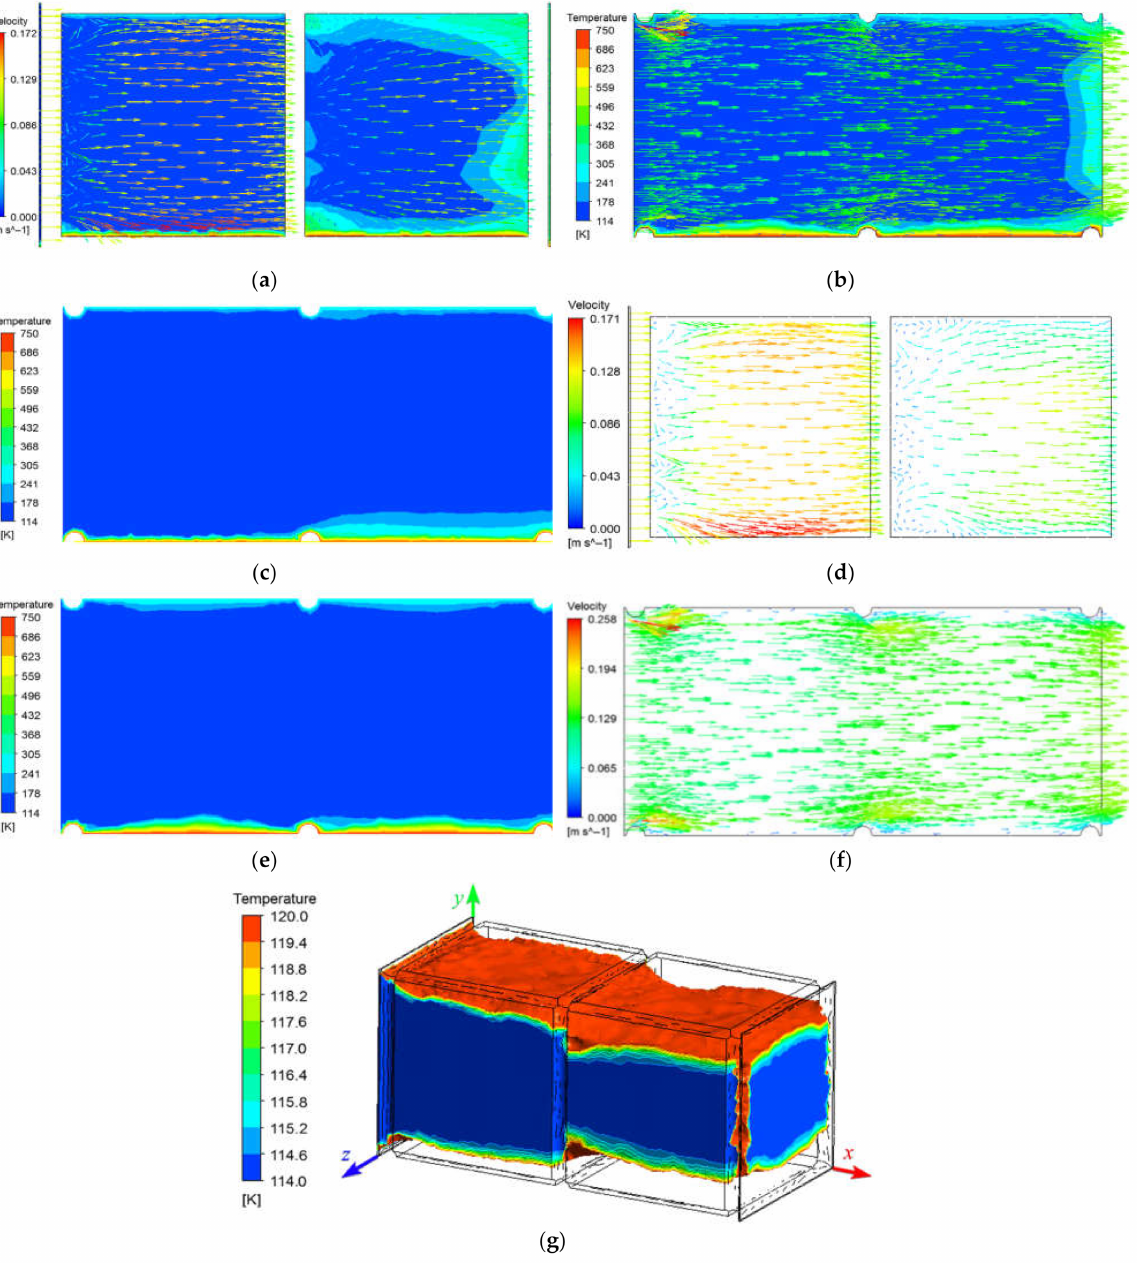
Figure 6. Distribution of temperature and velocity field of the grid type lattice: ( a ) temperature (K) and velocity variation (m/s), for z = 0.012 m, t = 0.2 s; ( b ) temperature (K) and velocity variation (m/s), for z = 0.006 m, t = 0.2 s; ( c ) temperature variation (K), for z = 0.012 m, t = 0.45 s; ( d ) velocity variation (m/s), for z = 0.012 m, t = 0.45 s; ( e ) temperature variation (K), for z = 0.006 m, t = 0.45 s; ( f ) velocity variation (m/s), for z = 0.006 m, t = 0.45 s; ( g ) fluid with a temperature greater than 120 K, for t = 0.45